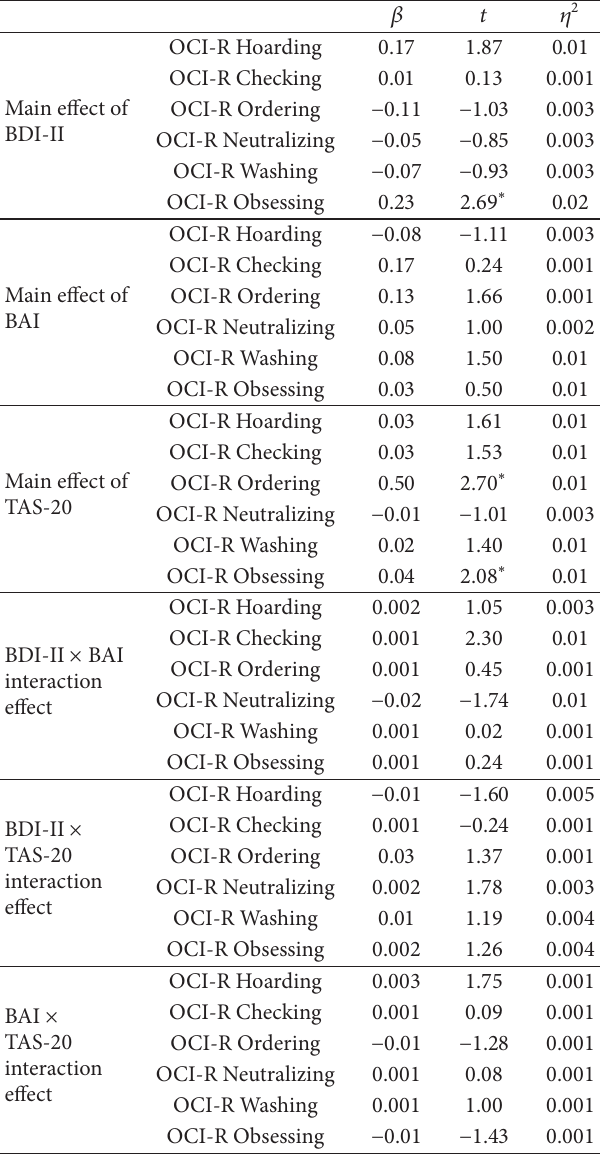
Table 3: Beta coefficients of BDI-II, BAI, and TAS-20 DIF on the OCI-R Total ( 𝑛 = 425).